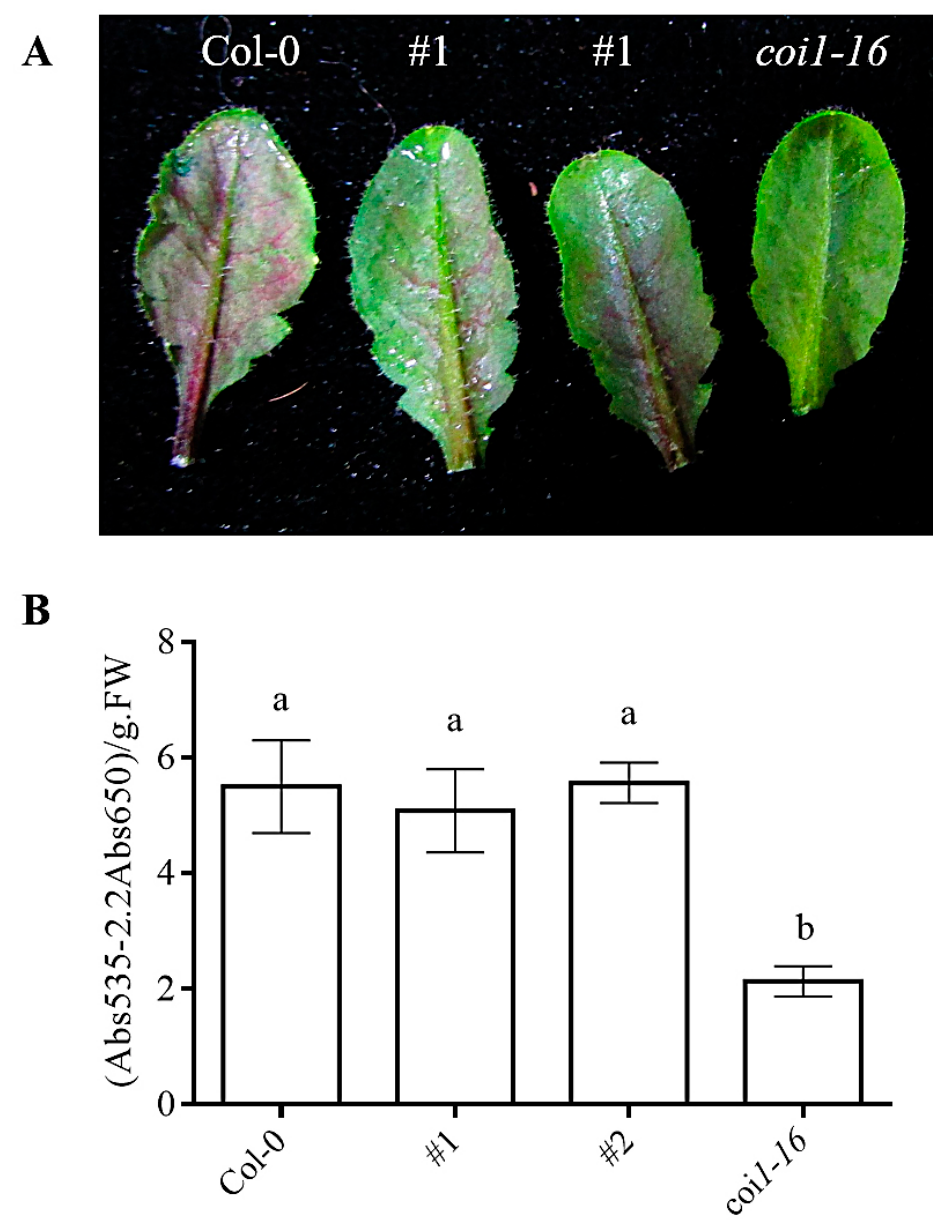
Figure 8. The anthocyanin accumulation in Col-0, #1, #2, and coi1-16 mutant. The overall appearance of Arabidopsis plants after treatment of 50 µ M MeJA for 48 h ( A ); the accumulation content measured from 1 g leaf tissue from MeJA-treated Col-0, #1, #2, coi1-16 ( B ). The error bar represents the mean ( ± standard error) of at least three biological replicates. Columns marked with di ff erent letters ( a , b ) are significantly di ff erent from the others (ANOVA followed by Tukey’s multiple comparison test ( p < 0.05)).